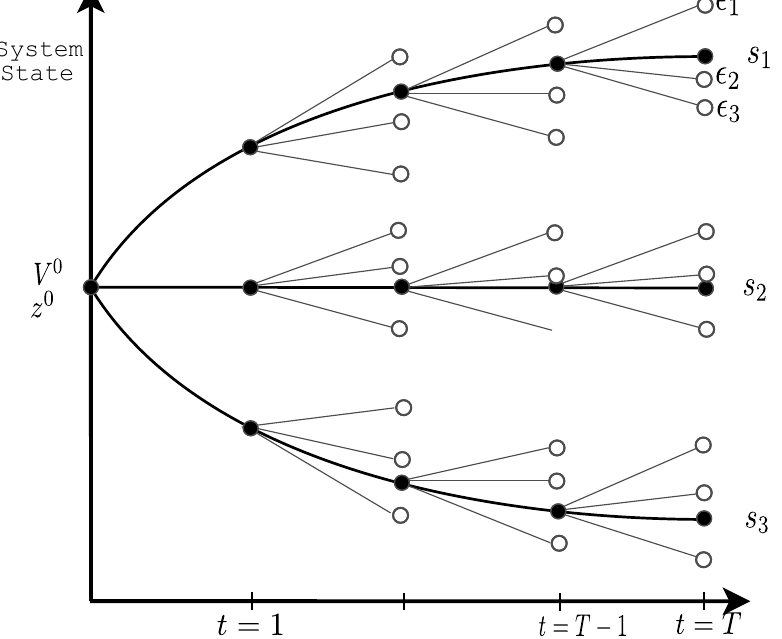
Figure 1. Illustration of a main iteration in the stochastic dual dynamic programming (SDDP) algorithm. Circles indicate system states, and branches correspond to realizations of stochastic